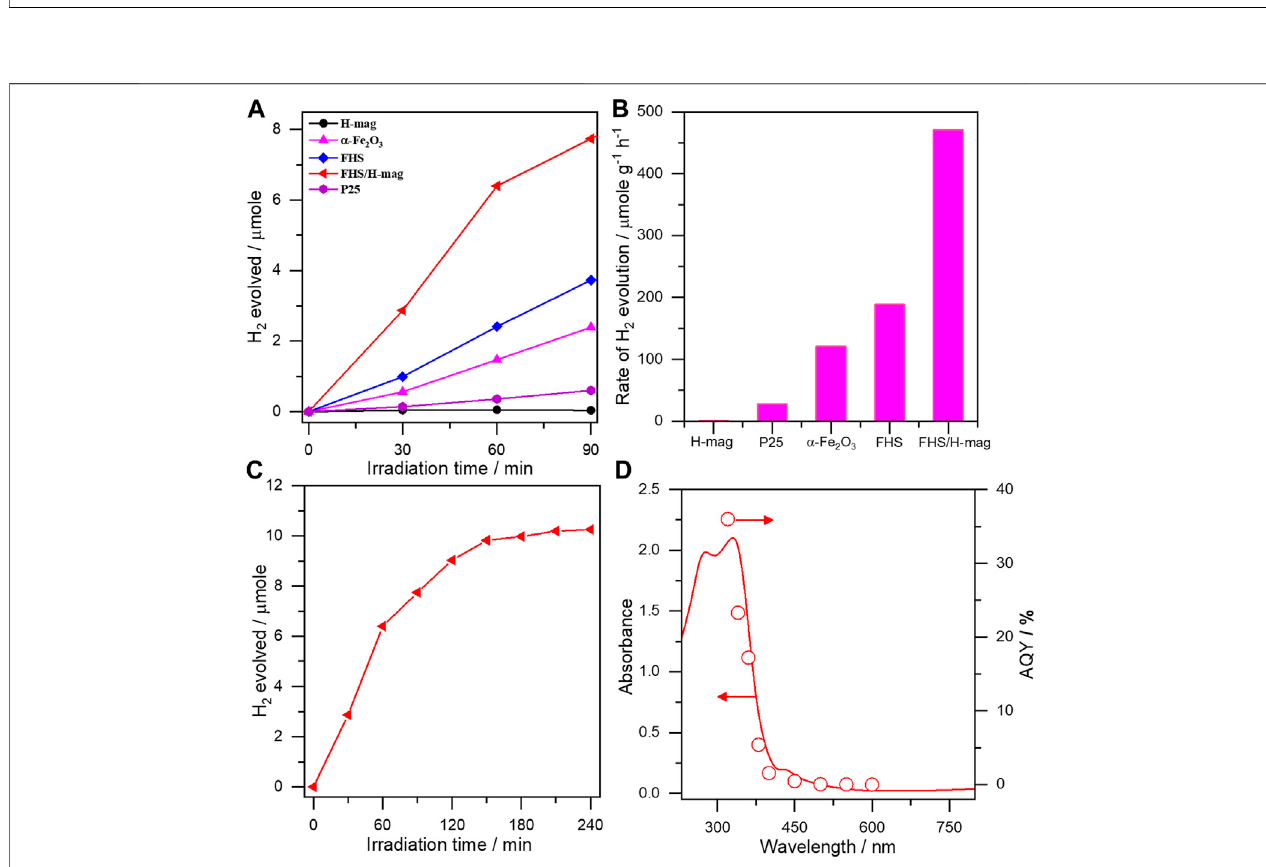
FIGURE 6 | (A) H 2 evolution pro fi les (B) H 2 evolution rates on different materials from a deaerated aqueous solution containing FA under solar simulator irradiation (C) Durability test for FHS/H-mag and (D) Action spectrum in photocatalytic dehydrogenation of FA on FHS/H-mag.